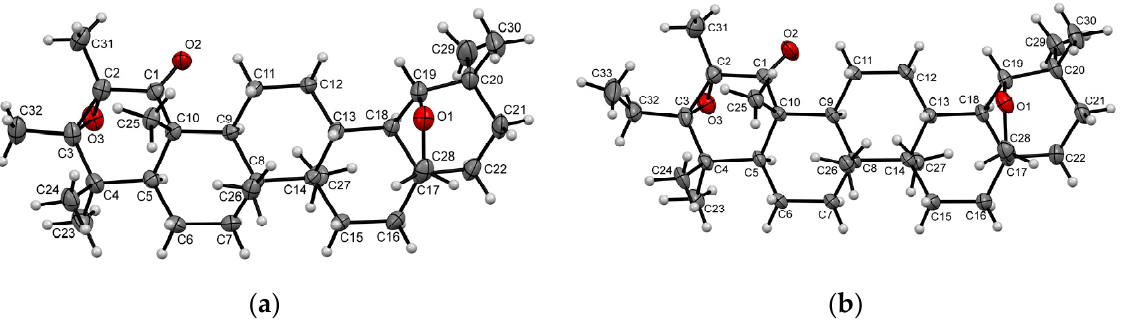
Figure 2. Molecular structures of compounds 16 ( a ) and 17 ( b ) with atoms represented as thermal vibration ellipsoids, with 50% probability.